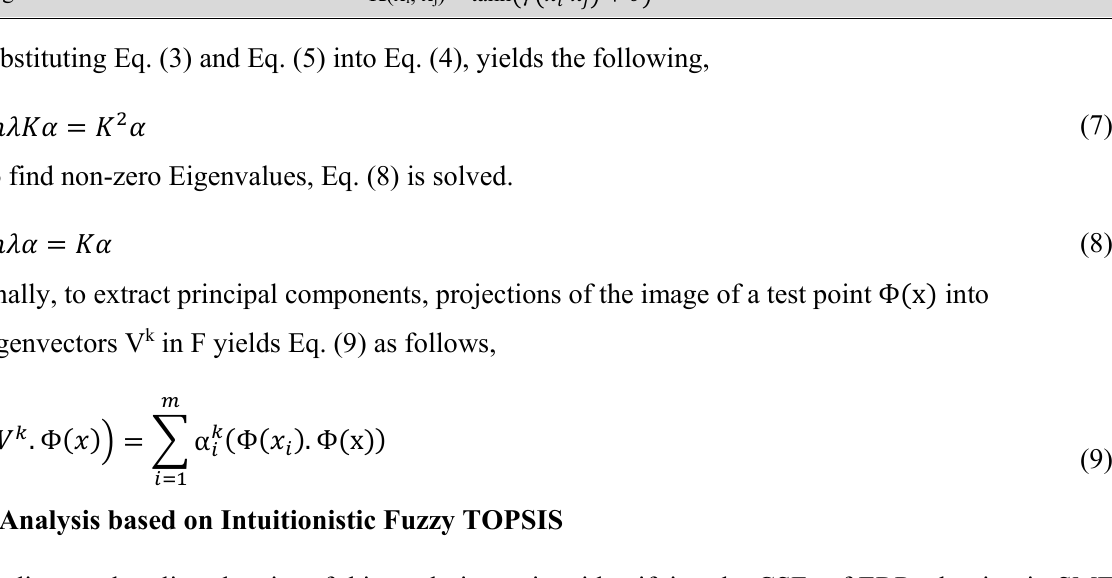
(cid:2870) /2(cid:2026) (cid:2870) (cid:4673) i , x j ) = exp (cid:4672)(cid:3398)(cid:3630)(cid:1876) (cid:3036) (cid:3398) (cid:1876) (cid:3037) (cid:3630) (cid:3083) (cid:3036)(cid:3021) (cid:1876) (cid:3397) (cid:2011)(cid:3439) i , x j ) = (cid:3435)(cid:1876) (cid:3037) (cid:3036)(cid:3021) (cid:1876) (cid:3439) (cid:3397) (cid:2016)(cid:3439) i , x j ) = tanh (cid:3435)(cid:2011)(cid:3435)(cid:1876) (cid:3037)